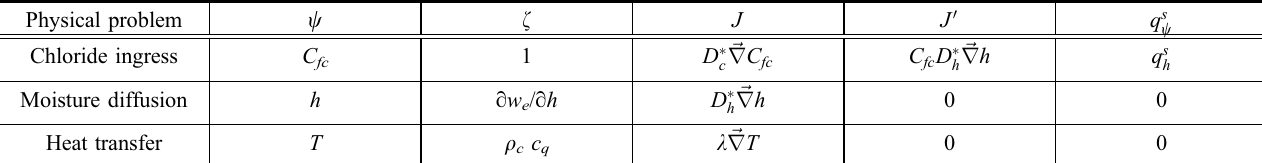
Fig. 1 Description of the corrosion-fatigue deterioration process in RC structures. Table 1 Correspondence between Eq. (1) and the governing differential equations.